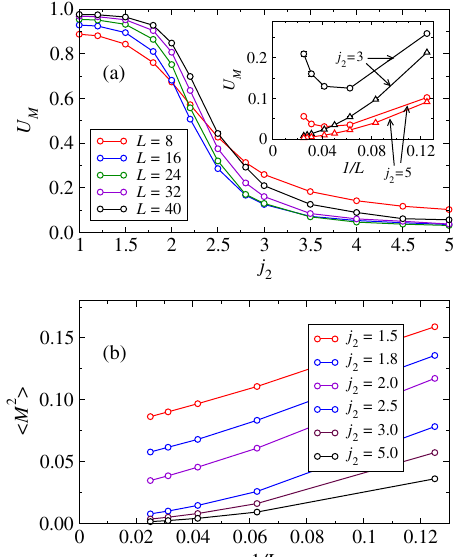
FIG. 7. Results for the diluted J 1 - J 2 model at vacancy fraction p ¼ 1 = 32 . (a) AFM Binder cumulant vs the coupling ratio for different system sizes. The inset shows the size dependence for j 2 ¼ 3 and 5 for both diluted (circles) and intact (triangles) systems. (b) The size dependence of the squared sublattice magnetization for several values of the coupling ratio. Error bars are smaller than the symbol size in all